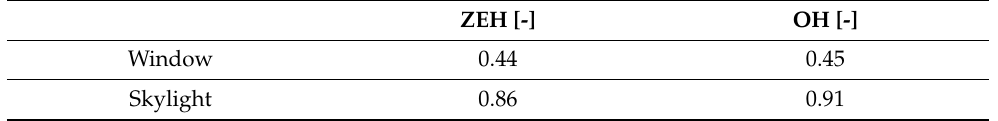
Table 4. Radiation shading factor compared between the ZEH and OH.